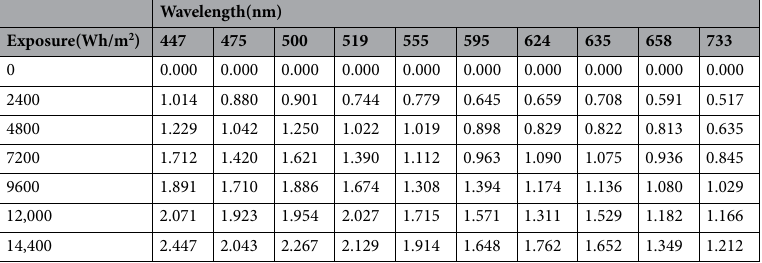
Table 1. The color difference values of graphite pigment in different exposure periods under irradiation of 10 narrow-band